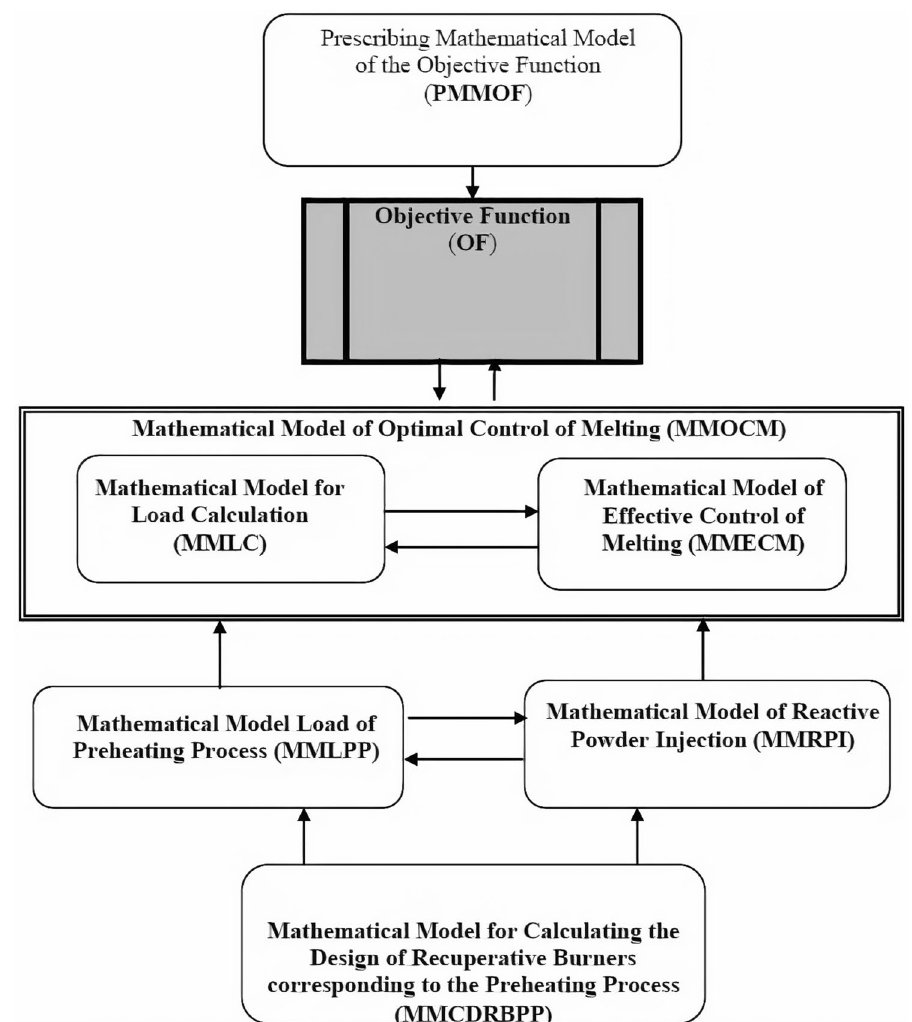
Fig. 20 Optimization control block diagram